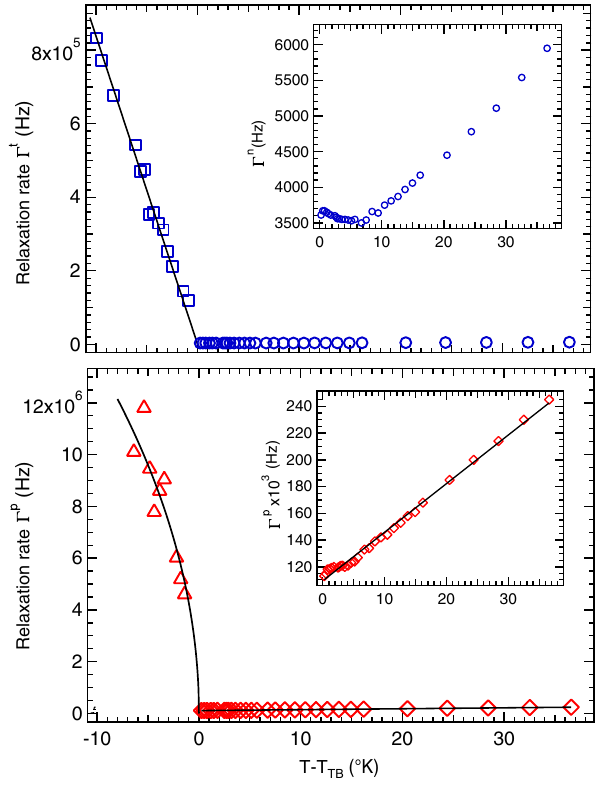
FIG. 6. Top panel: Temperature dependence of relaxation rates associated with director fluctuations detected in scattering geom- etry G2 in the uniaxial nematic phase ( Γ n for T > T main figure and inset) and twist-bend phase ( Γ t for T < T squares in main figure) with fixed θ i ¼ 15 ° and θ s ¼ 40 ° (see Fig. 2, top right). Bottom panel: Temperature dependence of the relaxation rate of polarization fluctuations in the nematic (dia- monds in main figure and inset for θ s ¼ 40 ° and θ i ¼ 15 °) and N (triangles in main figure for θ s ¼ 0 °, θ i ¼ 35 °) phases. The TB solid lines in both panels are fits of Γ t and Γ p to calculated results from the coarse-grained free-energy density model presented in Sec. IV of the text.